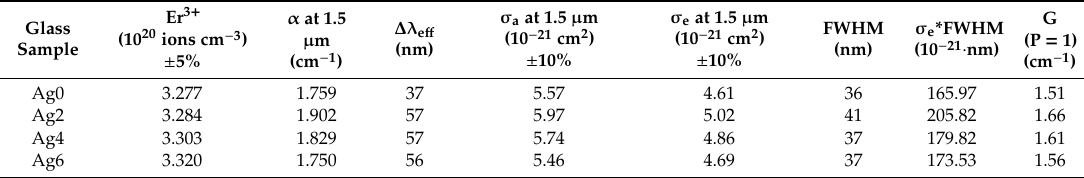
Table 6. Optical properties of as-prepared glasses.